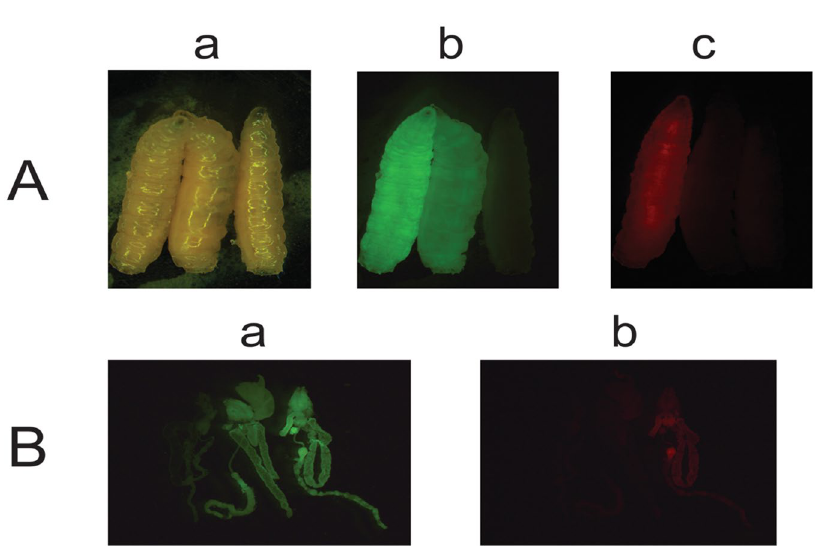
Figure 2. The Lcact5C gene promoter directs expression of the tdTomato (RFPto) marker in most cells but predominantly in gut. Whole body ( A ) and dissected gut tissues ( B ) from L. cuprina 3 rd instar marked with constitutively expressed fluorescent protein marker genes. The larvae in ( A ) were from pBac-Lch83 promoter- ZsGreen -Lcactin5C promoter-RFPto transformed homozygous line (left), pBac-Lch83 promoter-ZsGreen transformed homozygous line (middle) and wild type (right), respectively, and the photos were taken under white light (a), GFP filter (b) and DsRed filter (c). The dissected gut tissues in ( B ) were from wild type (left), pBac-Lch83 promoter-ZsGreen transformed homozygous line (middle) and pBac-Lch83 promoter-ZsGreen -Lcactin5C promoter-RFPto transformed homozygous line (right), and the images were taken under GFP filter (a) and DsRed filter